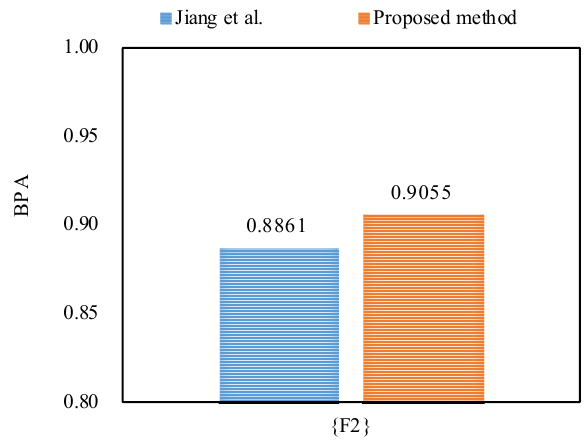
Figure 5. The comparison of the BPA of the target F 2 at 1 X frequency.